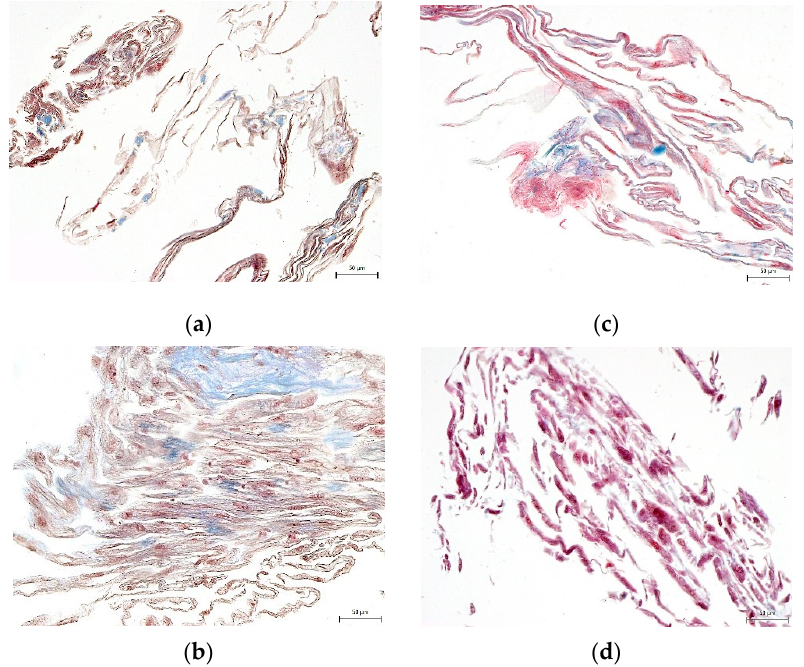
Figure 8. Detection of collagen and procollagen in the extracellular chondrogenic mass of DPSCs after 3-week cultivation in a chondrogenic differentiation medium. After histological staining using blue Masson’s trichrome, the collagen and procollagen appear as blue areas: ( a ) 10% DMSO cryomedium; ( b ) 3% DMSO cryomedium; ( c ) 3% DMSO + 0.1% HMW-HA cryomedium; ( d ) non-differentiated DPSCs. Scale bar 50 µ m.